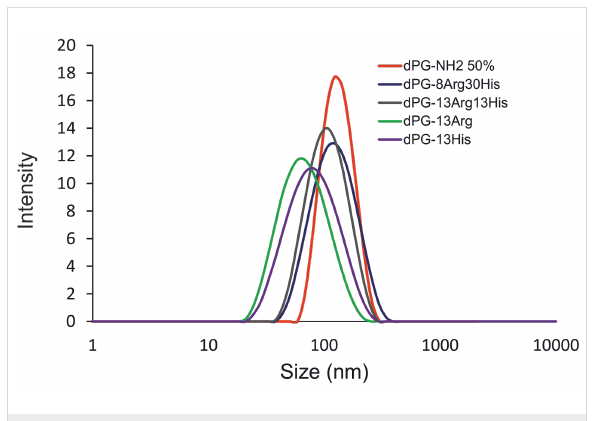
Figure 2: Size measurements of dPG-NH 2 50% and AAdPGs/siRNA complexes. Intensity distributions of all polyplexes are